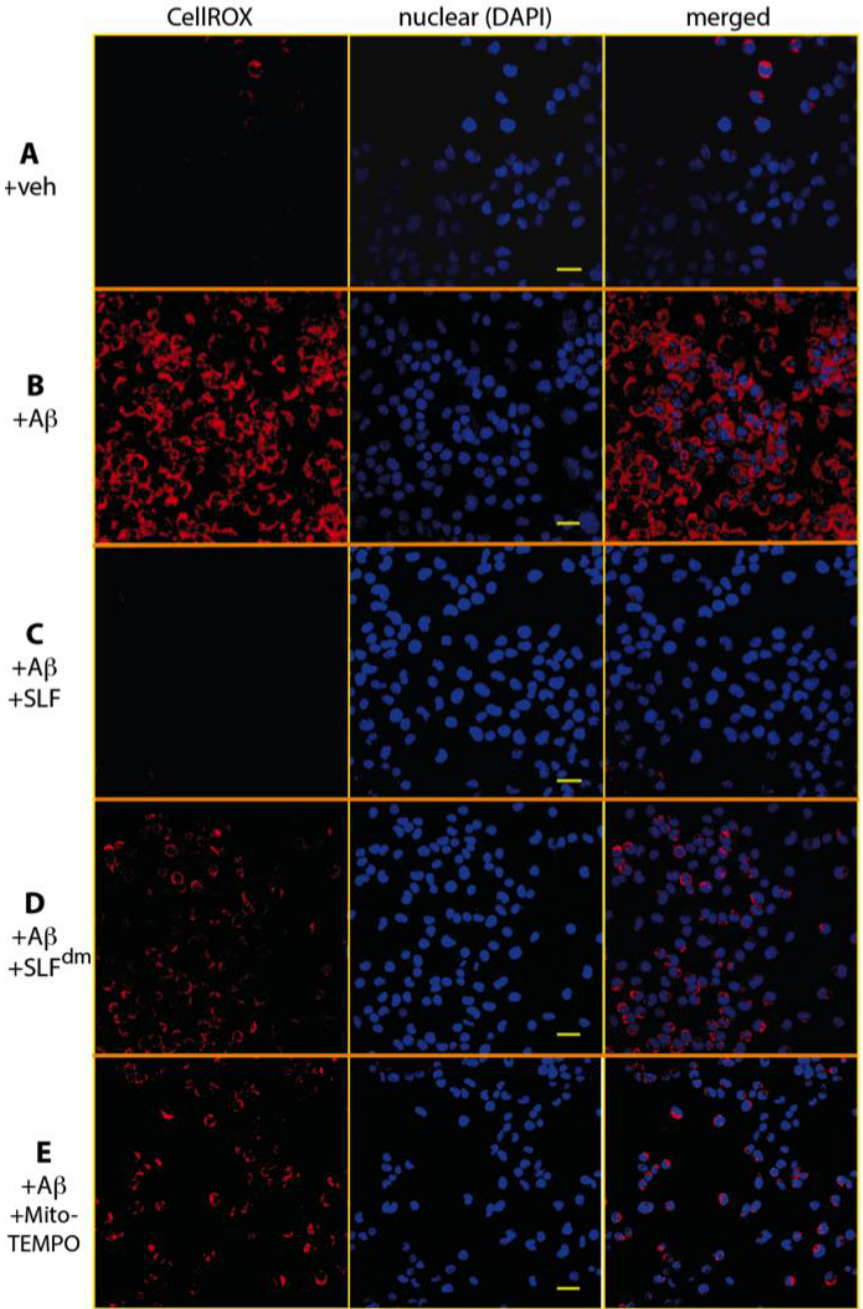
Figure 5. The nitroxide moiety of SLF has extensive ROS scavenging properties in N2a cells treated with 1 μM exogenous Aβ. ROS levels were imaged by confocal microscopy for the fluorogenic dye CellRox Deep Red (red punctae in image). A slight generation of ROS is evident with the vehicle control ( A ). Addition of Aβ elicits a strong ROS response ( B ). Images show decreased levels of the Aβ-induced ROS signal in the presence of SLF ( C ) while moderately high levels of ROS are evident in cells treated with the SLF lacking the nitroxyl moiety ( D ). The strong antioxidant activity of MitoTEMPO is evident in ( E ). In addition to the CellROX images (left column), the DAPI nuclear stain (middle column) and merged DAPI-CellRox images (right column) are shown. Scale bar represents 20 μm.